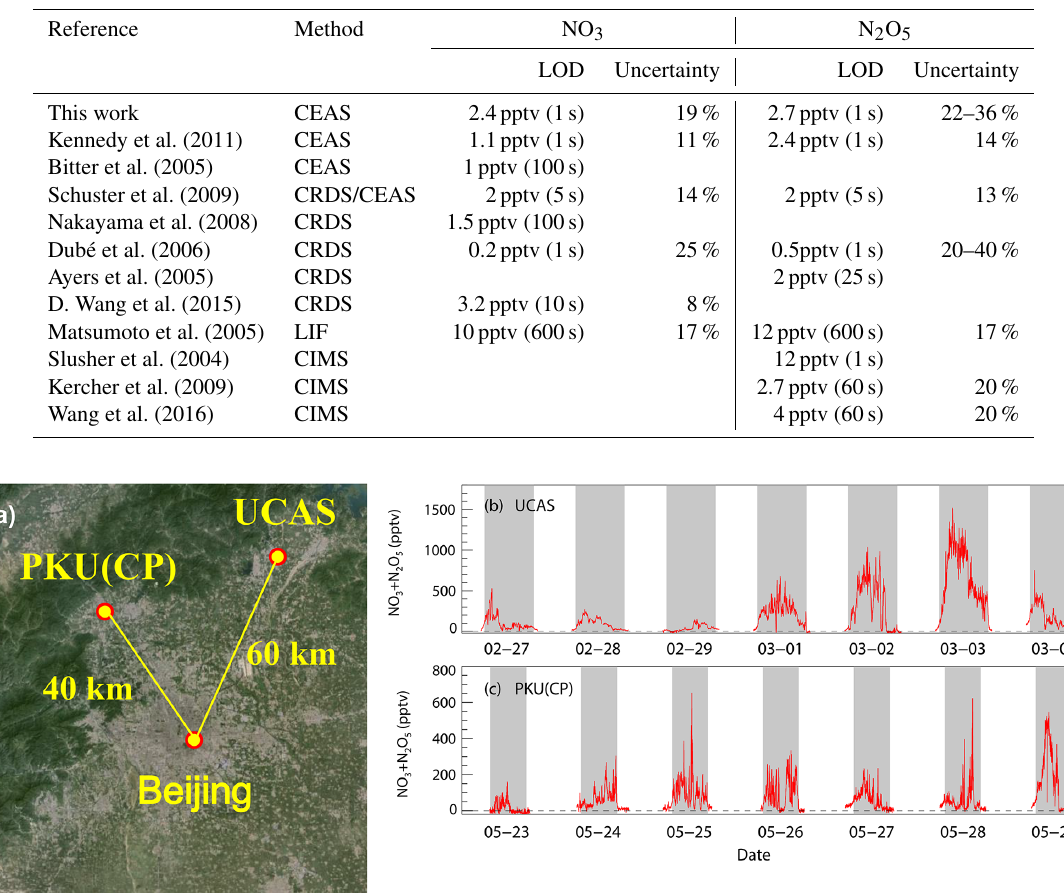
Table 3. Limits of detection (LODs) and uncertainty of the existing field-deployable instruments of NO 3 and N 2 O 5 .